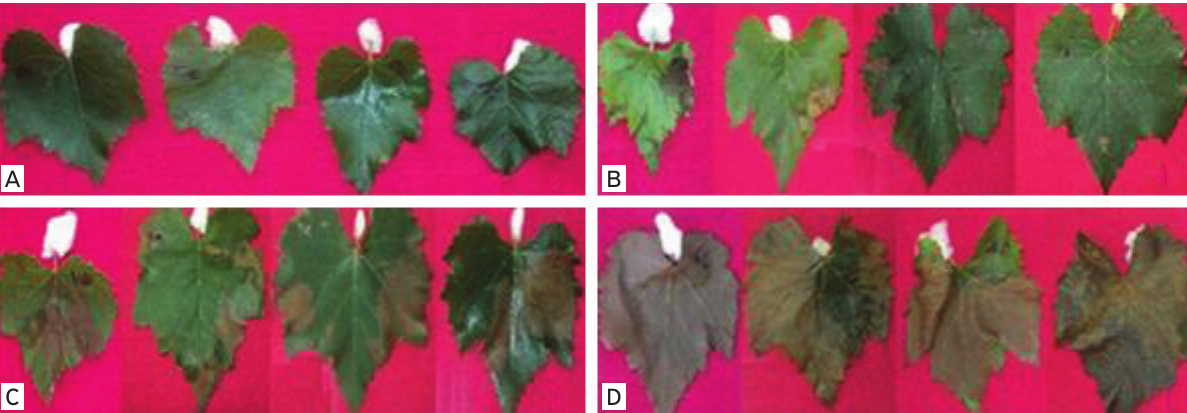
Figura 1. Escala estabelecida e utilizada para a avaliação da fitotoxicidade causada pelos óleos essenciais em folhas destacadas de videira; (A) ausência de sintomas de fitotoxicidade, (B) nível baixo, (C) nível médio e (D) nível alto de fitotoxicidade. Ilha Solteira (SP),